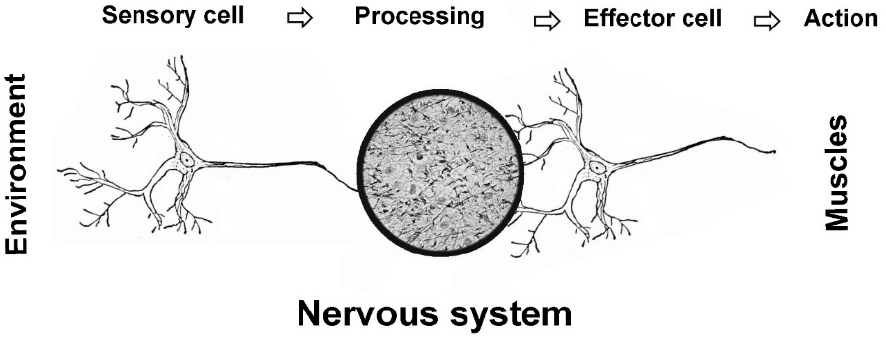
Figure 1. Overview of nervous systems. The majority of NS can be divided into three components: sensory cells detect environmental or internal information; this is sent to processing units (ganglia or brains) that decide on a response and execute the decision by sending signals to muscles via effector neurons.